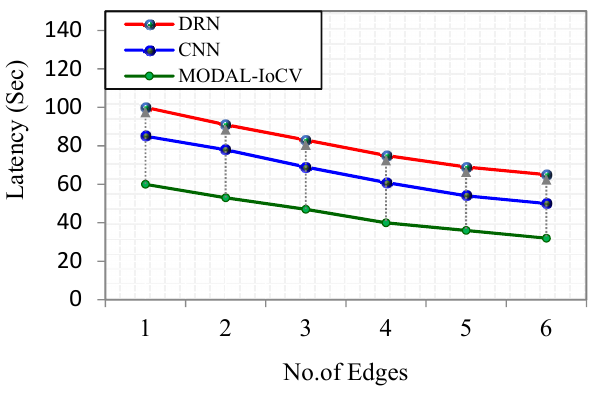
Figure 12. Number of edges vs. latency.